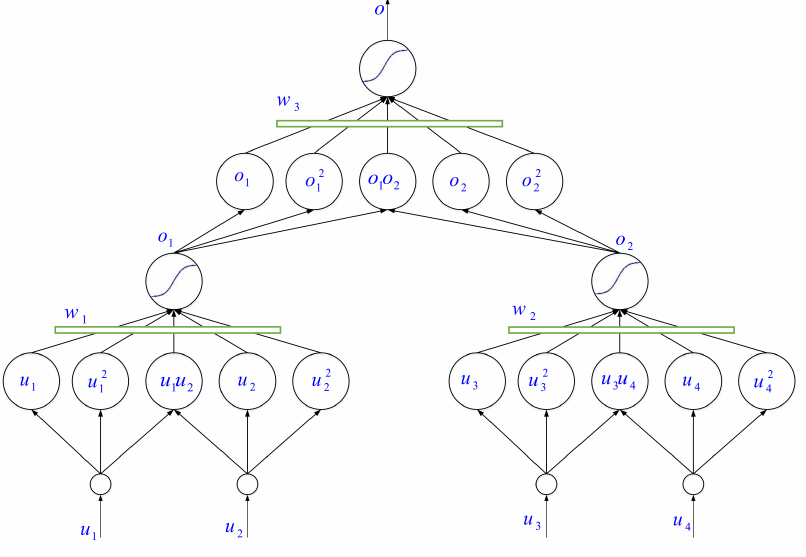
Figure 2. The proposed GMDH neural